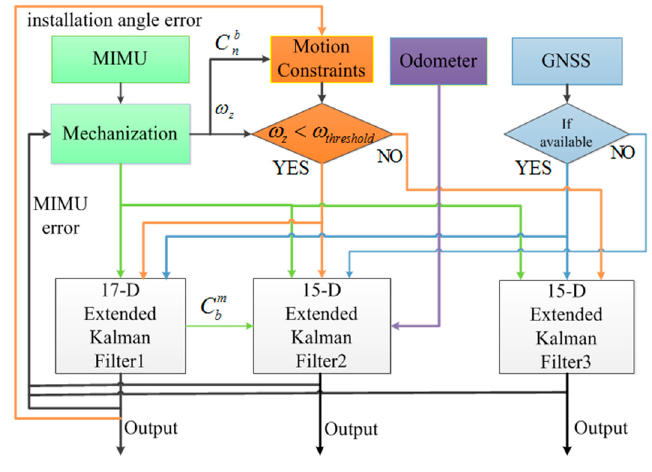
Figure 6. Navigation Algorithm Flowchart.